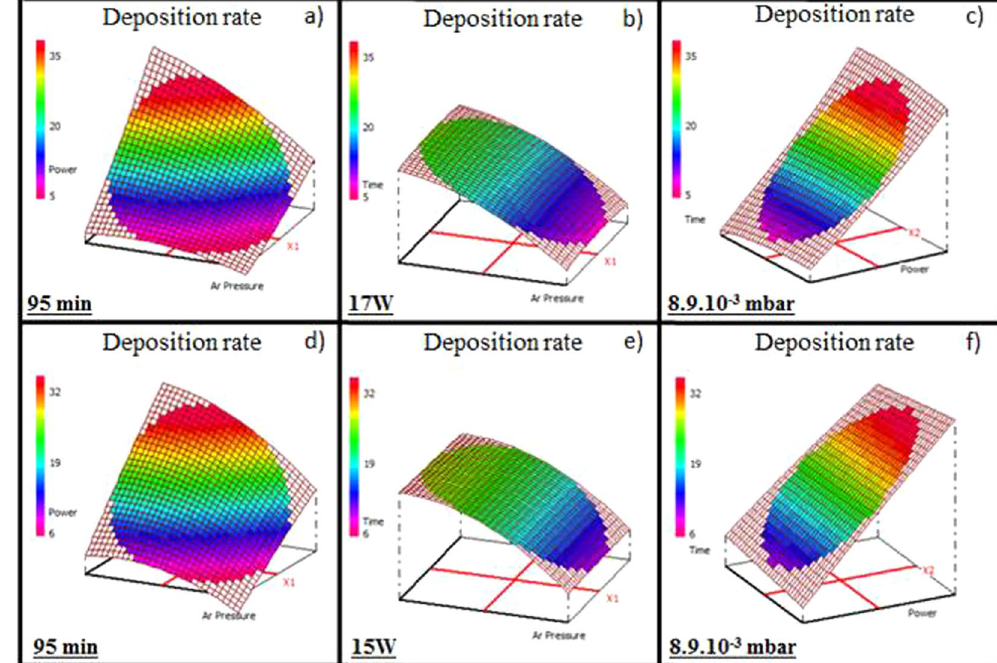
Figure 6. Variation of the deposition rate of the Ge 28.1 Sb 6.3 Se 65.6 thin films for ( a ) a fixed deposition time of 95 min, ( b ) a fixed working power of 17 W, ( c ) a fixed Ar pressure of 8.9.10 − 3 mbar and the Ge 12.5 Sb 25 Se 62.5 thin films for ( d ) a fixed deposition time of 95 min, ( e ) a fixed working power of 15 W, ( f ) a fixed Ar pressure of 8.9.10 − 3